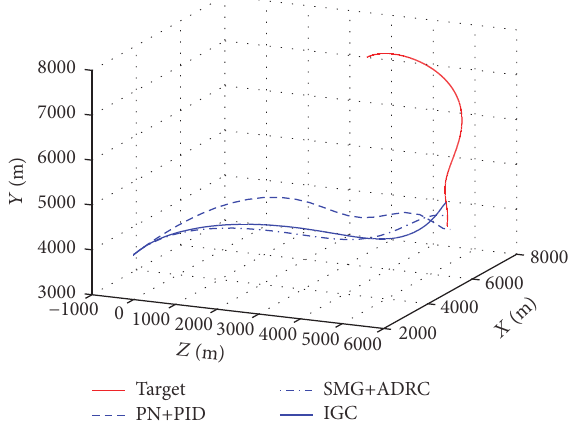
Figure 7: The interceptor-target relative motion in Scenario 2.